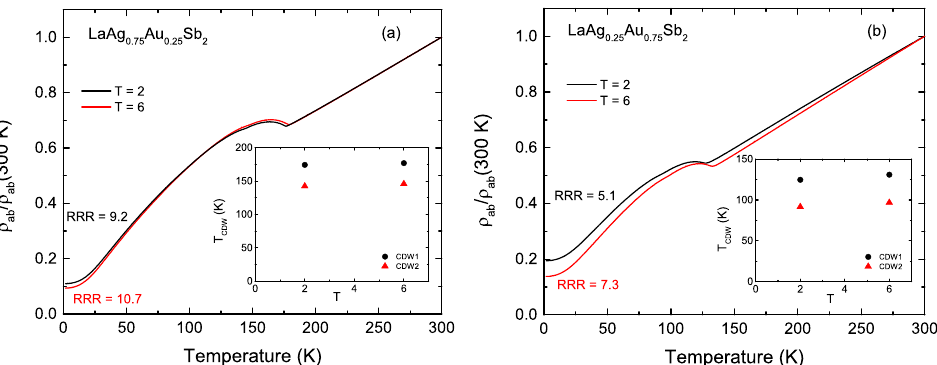
Figure 4. Normalized in-plane resistivity, ρ ab / ρ ab ( 300 K ) and the ordering temperatures CDW1 and CDW2 for T2 and T6 samples with nominal compositions ( a ) LaAg 0.75 Au 0.25 Sb 2 and ( b ) LaAg 0.25 Au 0.75 Sb 2